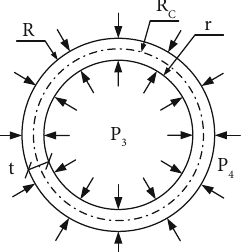
Figure 4: Calculation model of lining ring under uniform internal and external pressure.